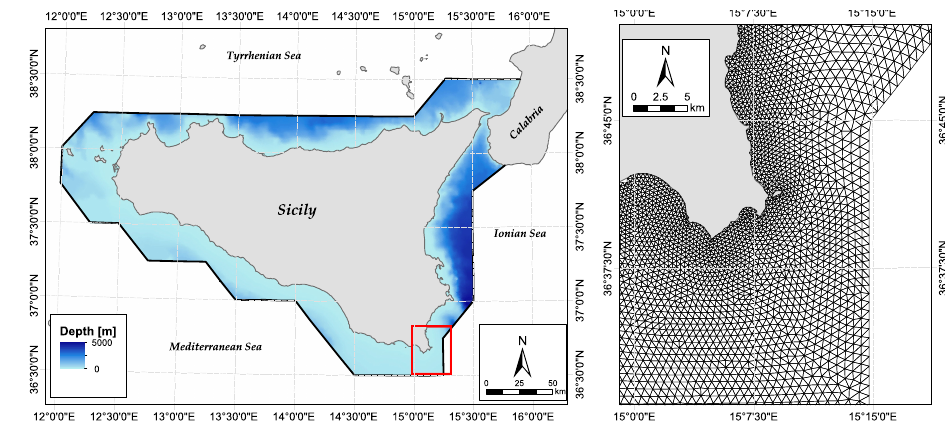
Figure 2. On the left: the bathymetry used to simulate wave propagation. On the right: detail of the model grid.